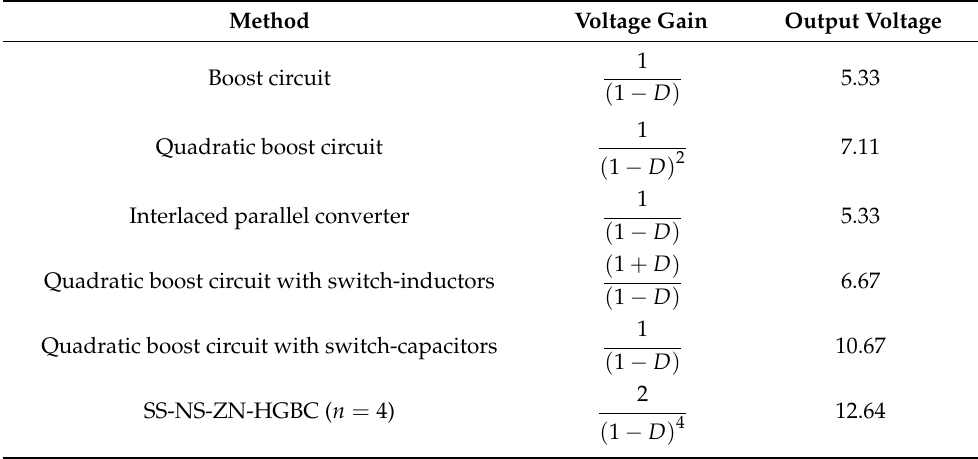
Table 5. Circuit parameters and number of